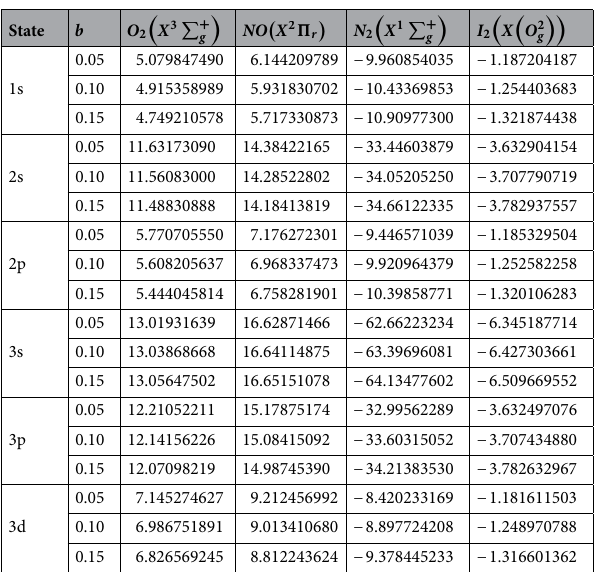
Table 2. Bound-states energy eigenvalues of the molecules studied in this work for various states.